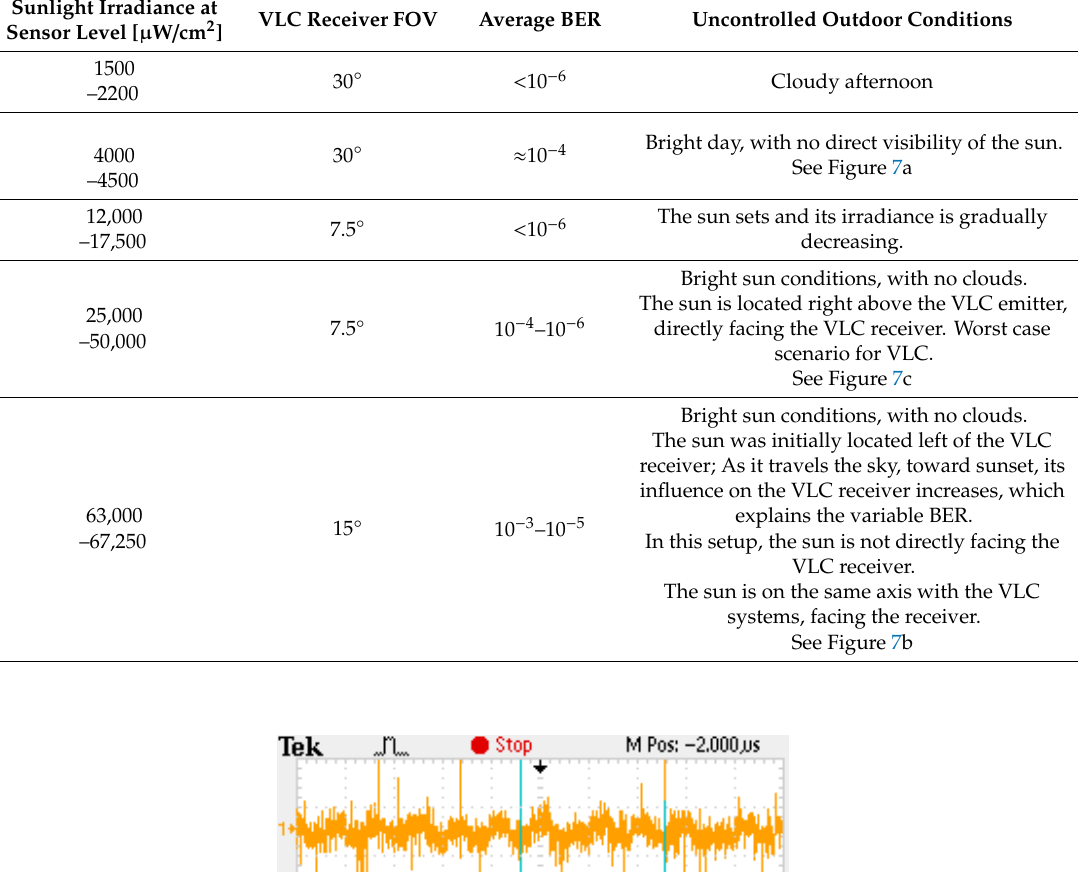
Table 7. Summary of the experimental evaluation of the VLC system in various outdoor conditions.